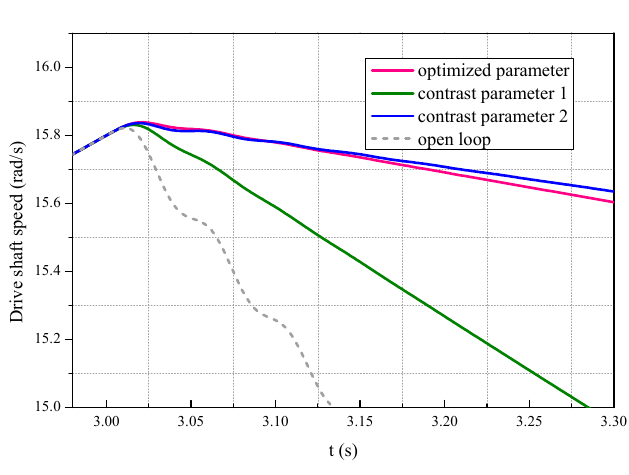
Figure 10. Motor speed oscillations.